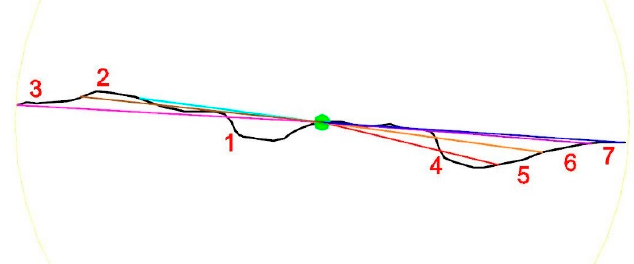
Figure 5. Investigation routes.